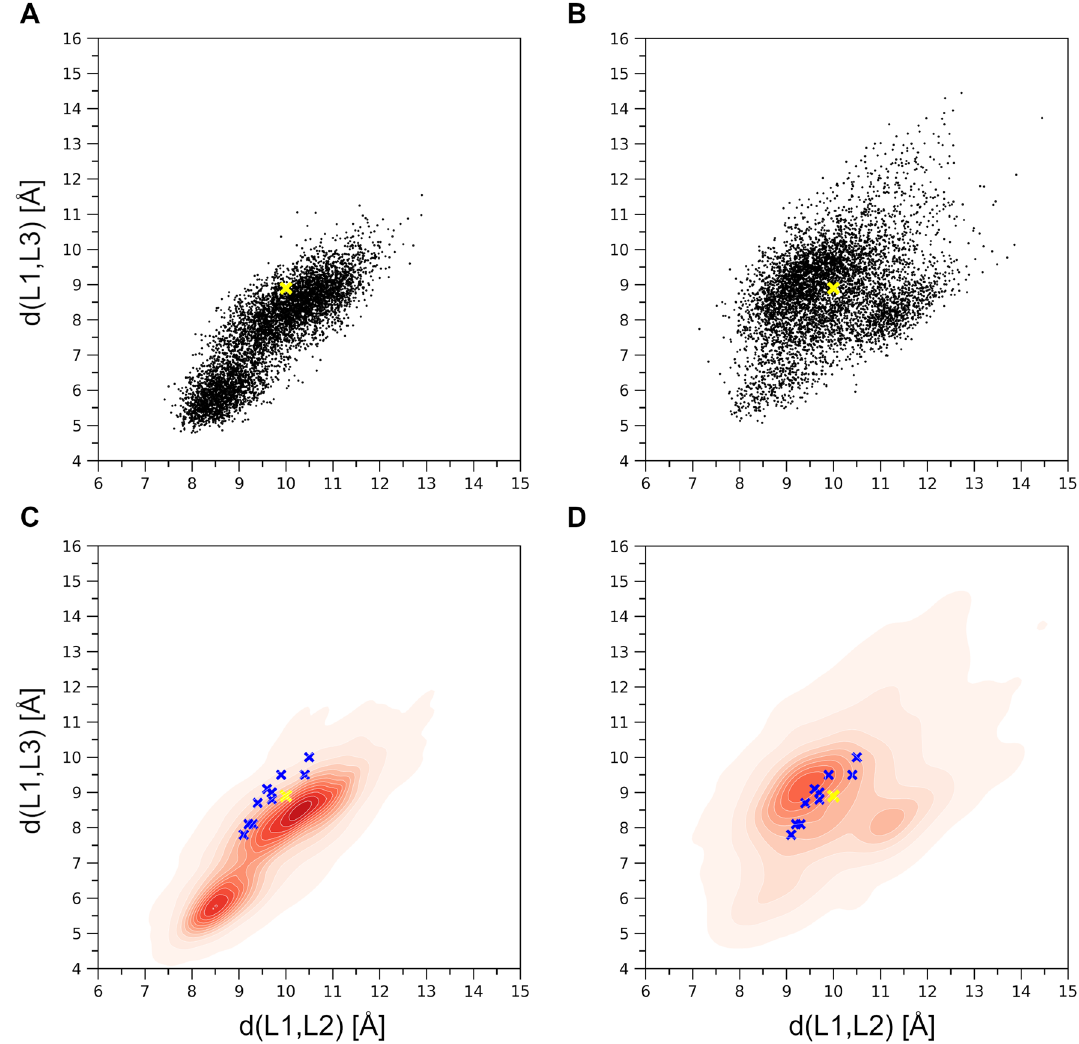
Figure 3. ( A ) Distribution of the d(L1,L2) and d(L1,L3) distances corresponding to the MD generated conformations; ( B ) Distribution corresponding to the MDeNM generated conformations; ( C ) Corresponding normalized distribution densities for the MD conformations and ( D ). for the MDeNM conformations. The available crystal structures (denoted by blue ‘x’-es) are plotted into the maps of (C, D); The location of the crystal structure (4GRA.pdb) is shown in yellow